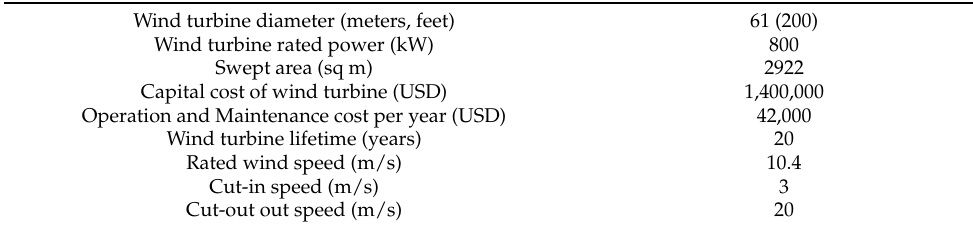
Table 2. Geometry and technical specifications of the BWT design [61].